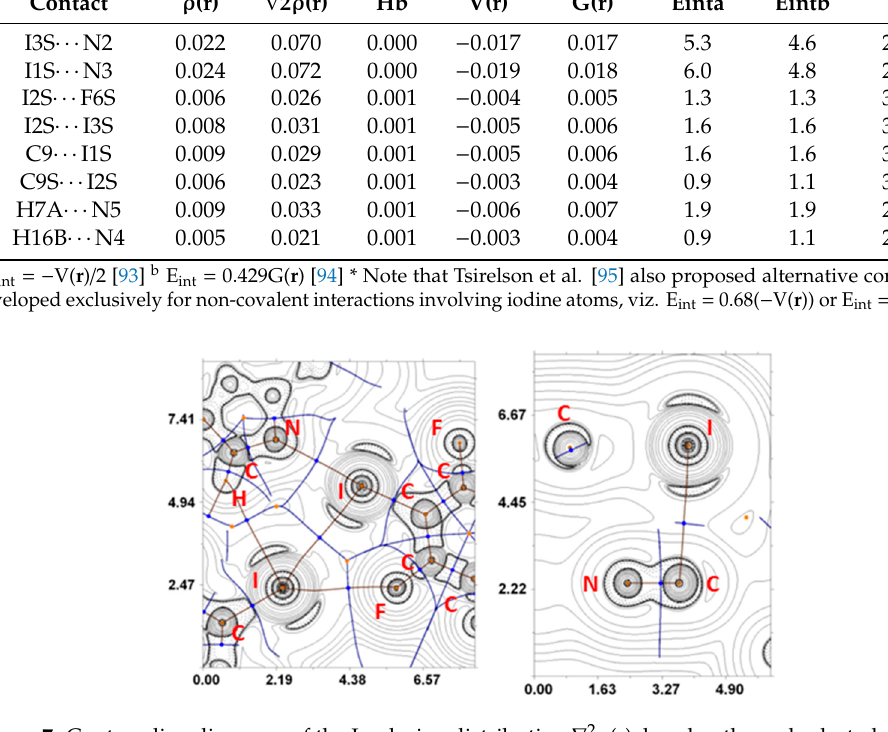
Figure 7. Contour line diagrams of the Laplacian distribution ∇ 2 ρ ( r ), bond paths and selected zero-flux surfaces referring to the C–I ··· X (X = N, F, I) halogen bonding (left) and lp(I) ··· π (triazole) (right) interactions in ( ASZ ) 3 · ( 1,4-FIB ) 4 . Bond critical points (3, − 1) are shown in blue, nuclear critical points (3, − 3) in pale brown, ring critical points (3, + 1) in orange, cage critical points (3, + 3) in light green. Length units—Å.